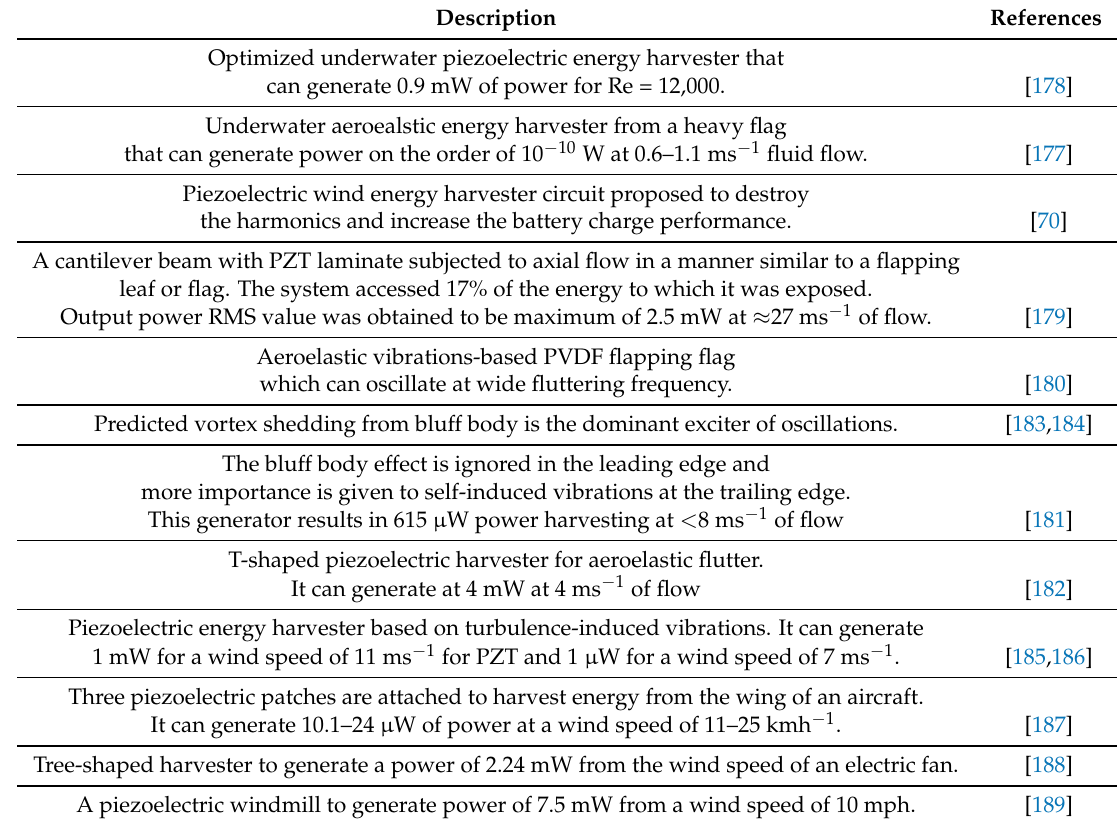
Table 3. Other mechanisms for FSI-based PEHs. Re: Reynolds number. Description